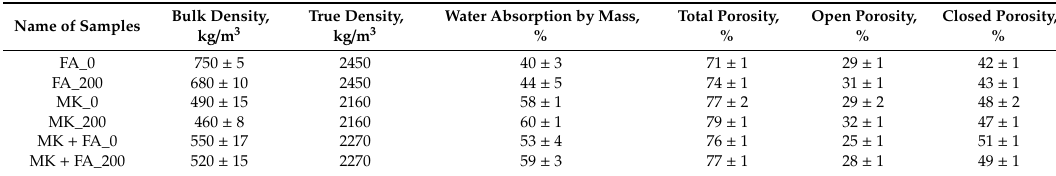
Table 3. Physical properties of